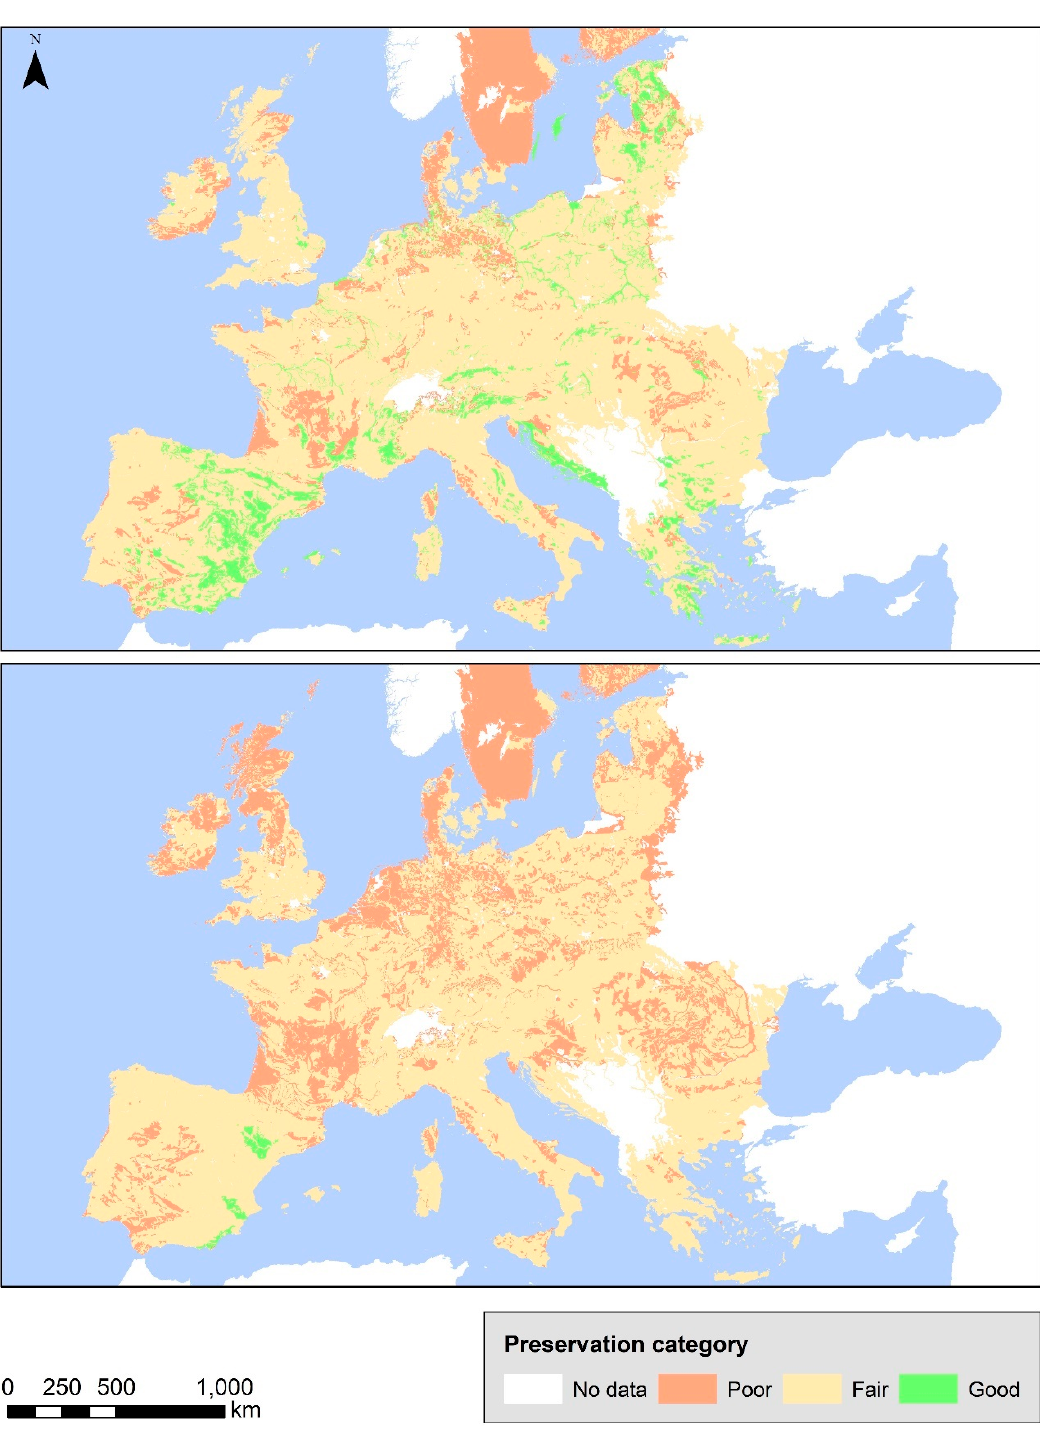
Figure 1. Preservation capacities of buried materials and stratigraphy across Europe for metals (top) and bones (bottom) (data source: References [32,35]).